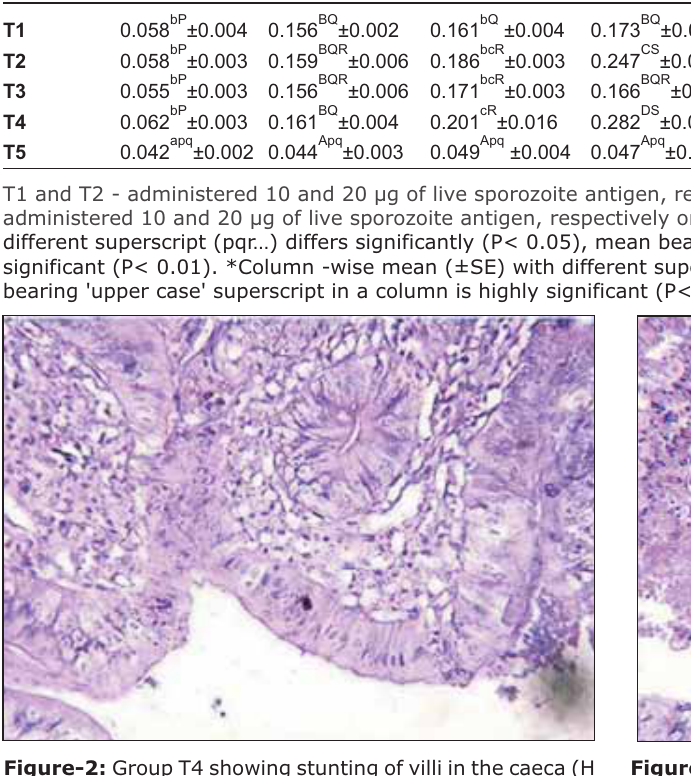
Table-1: Mean O.D.values of ELISA in the sporozoite immunized broiler chickens E. tenella Treatment OD values ( Mean ± SE) Groups